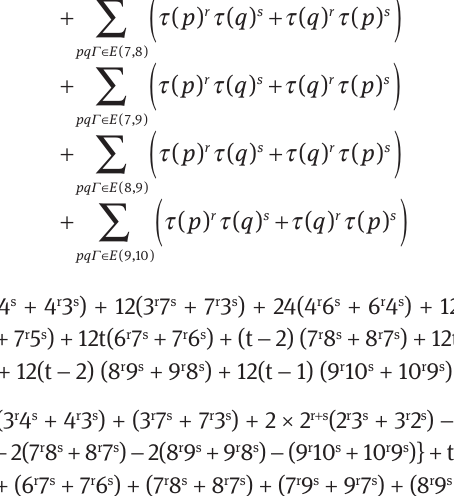
(t) that is based on 1